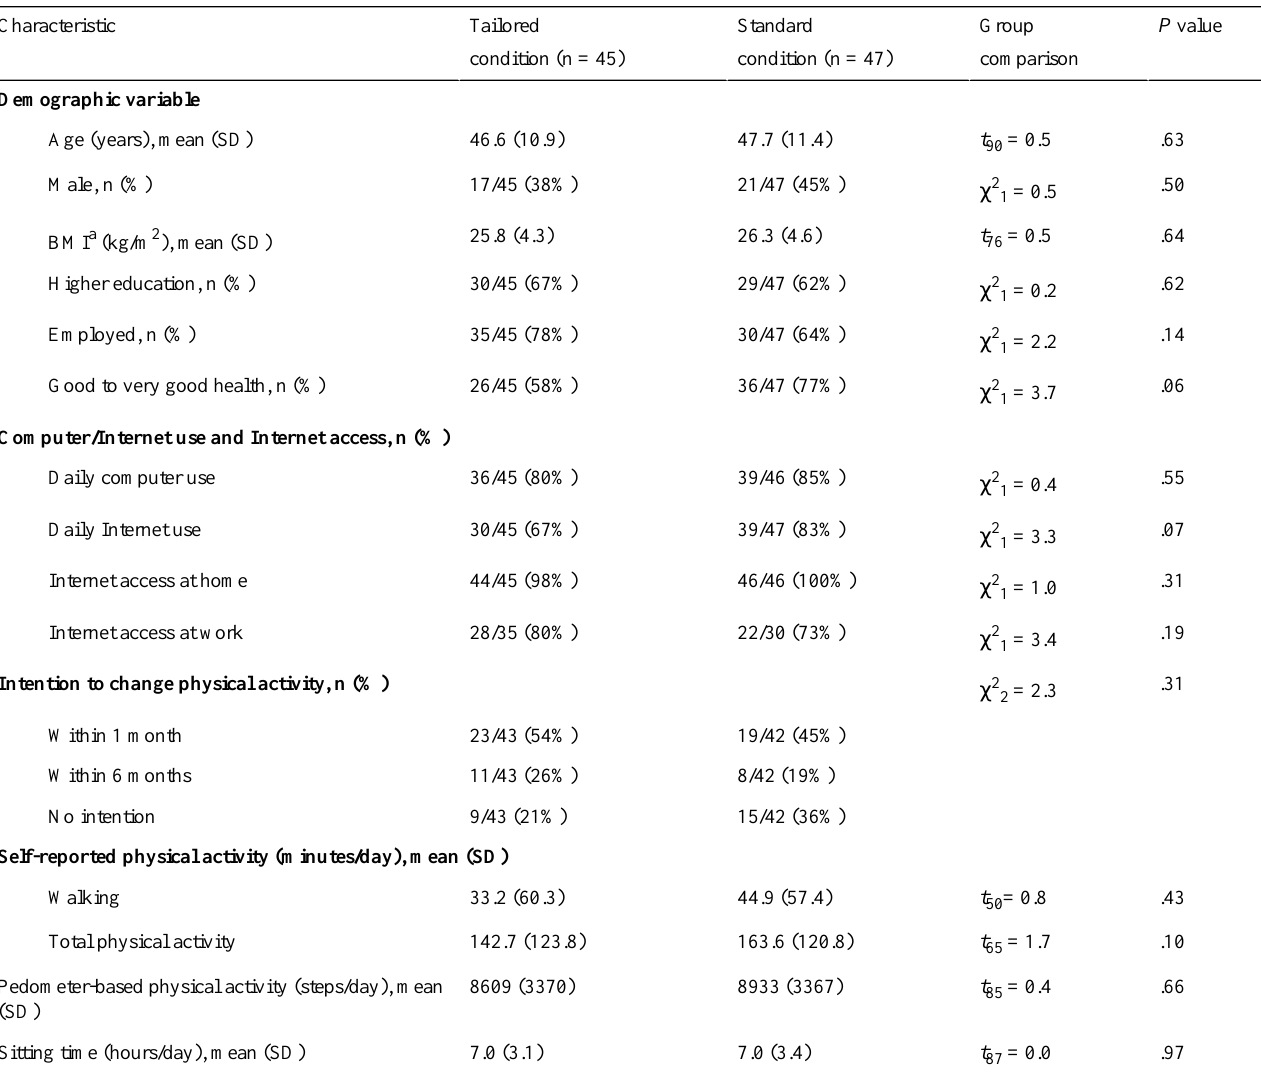
Table 2. Participant characteristics at